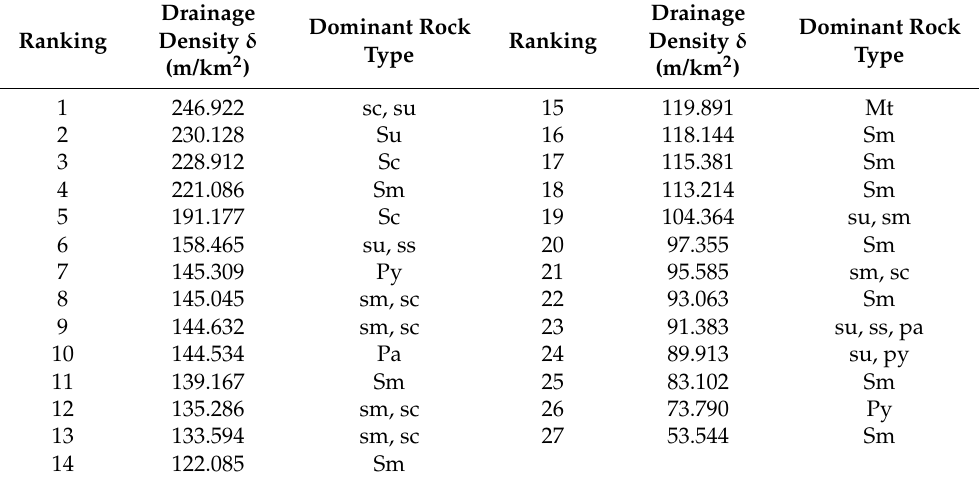
Table 2. Calculated drainage density ( δ ) and rock type in the sample areas in Hubei Province (see Table 1 for symbology).